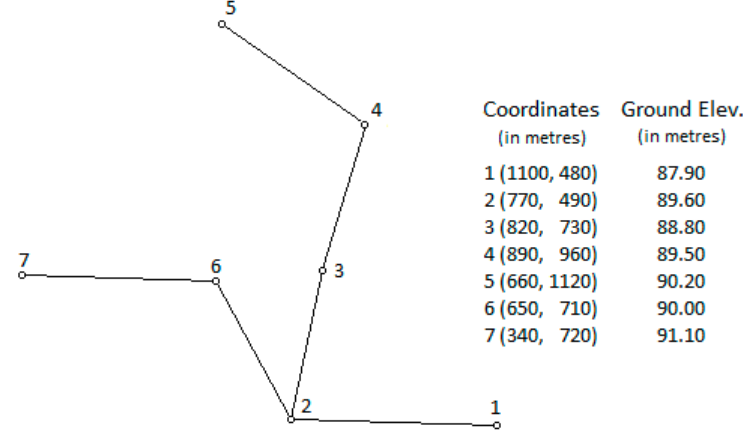
Figure 4. Simplified plant layout of the tested dendritic network.